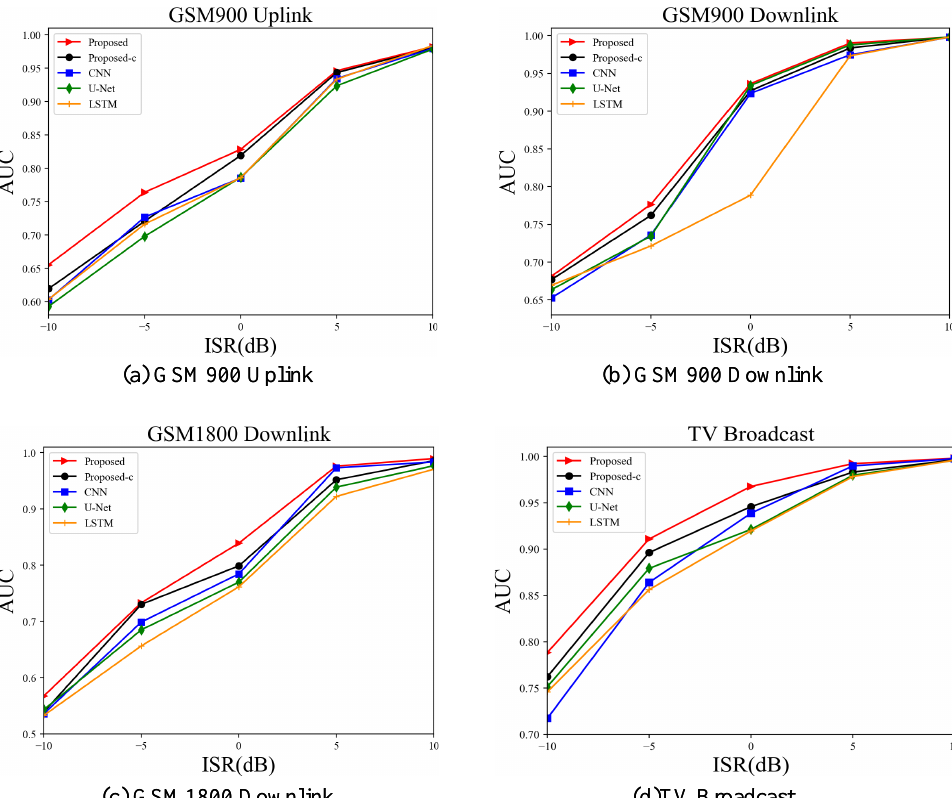
Figure 8. Anomaly detection performance for different